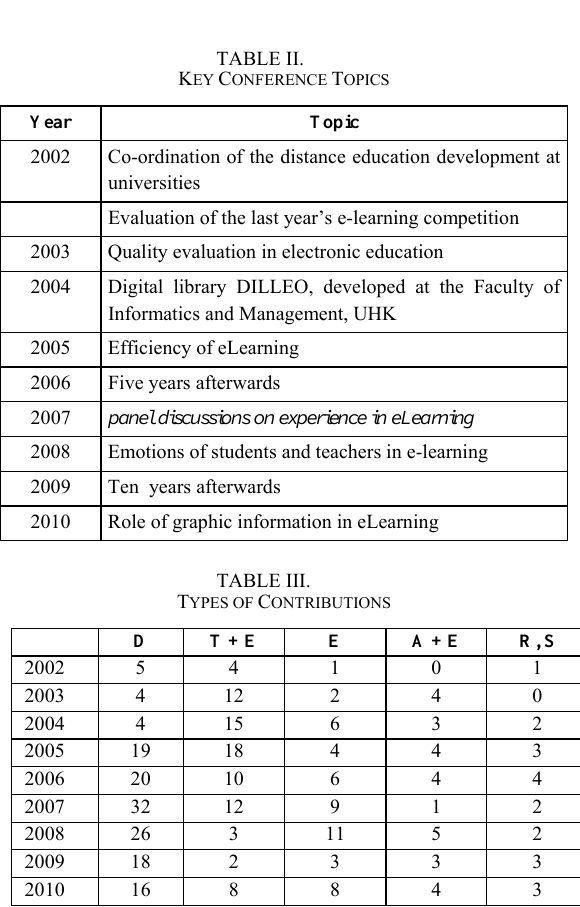
Figure 1. E-products, papers and their authors